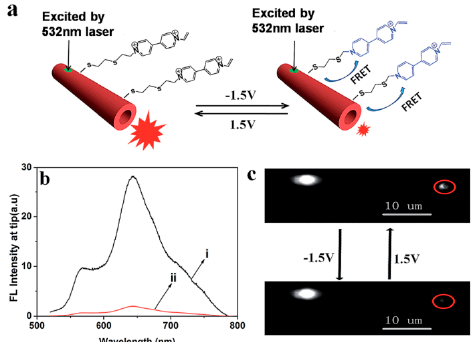
Figure 13. ( a ) Electrical modulation of waveguiding in the PDA microtube. ( b ) Tip emission spectra of the microtube with applied voltage of 1.5 V and − 1.5 V. ( c ) Fluorescence microscopy images collected upon excitation of the same microtube following driven voltage of 1.5 V and − 1.5 V (the whole Figure 13 was reprinted with permission from Yang et al. [57]).